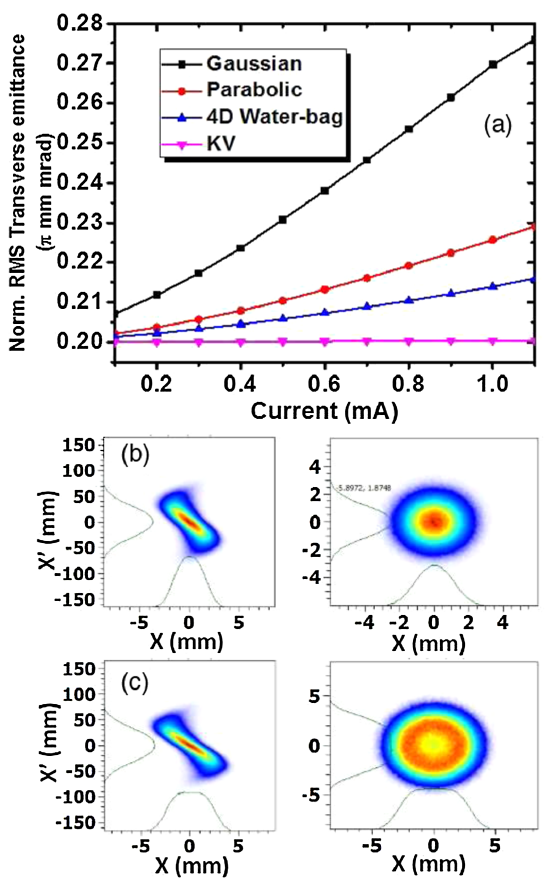
FIG. 4. (a) Normalized emittance (RMS) at the LEBT output as a function of the (compensated) beam current, for four different beam distributions, (b) phase space (left) and coordinate space (right) distributions at the LEBT exit for an initial Gaussian beam of current 500 μ A (below threshold) and (c) phase space (left) and coordinate space (right) distributions at the LEBT exit for an initial Gaussian beam of current 800 μ A (above threshold).